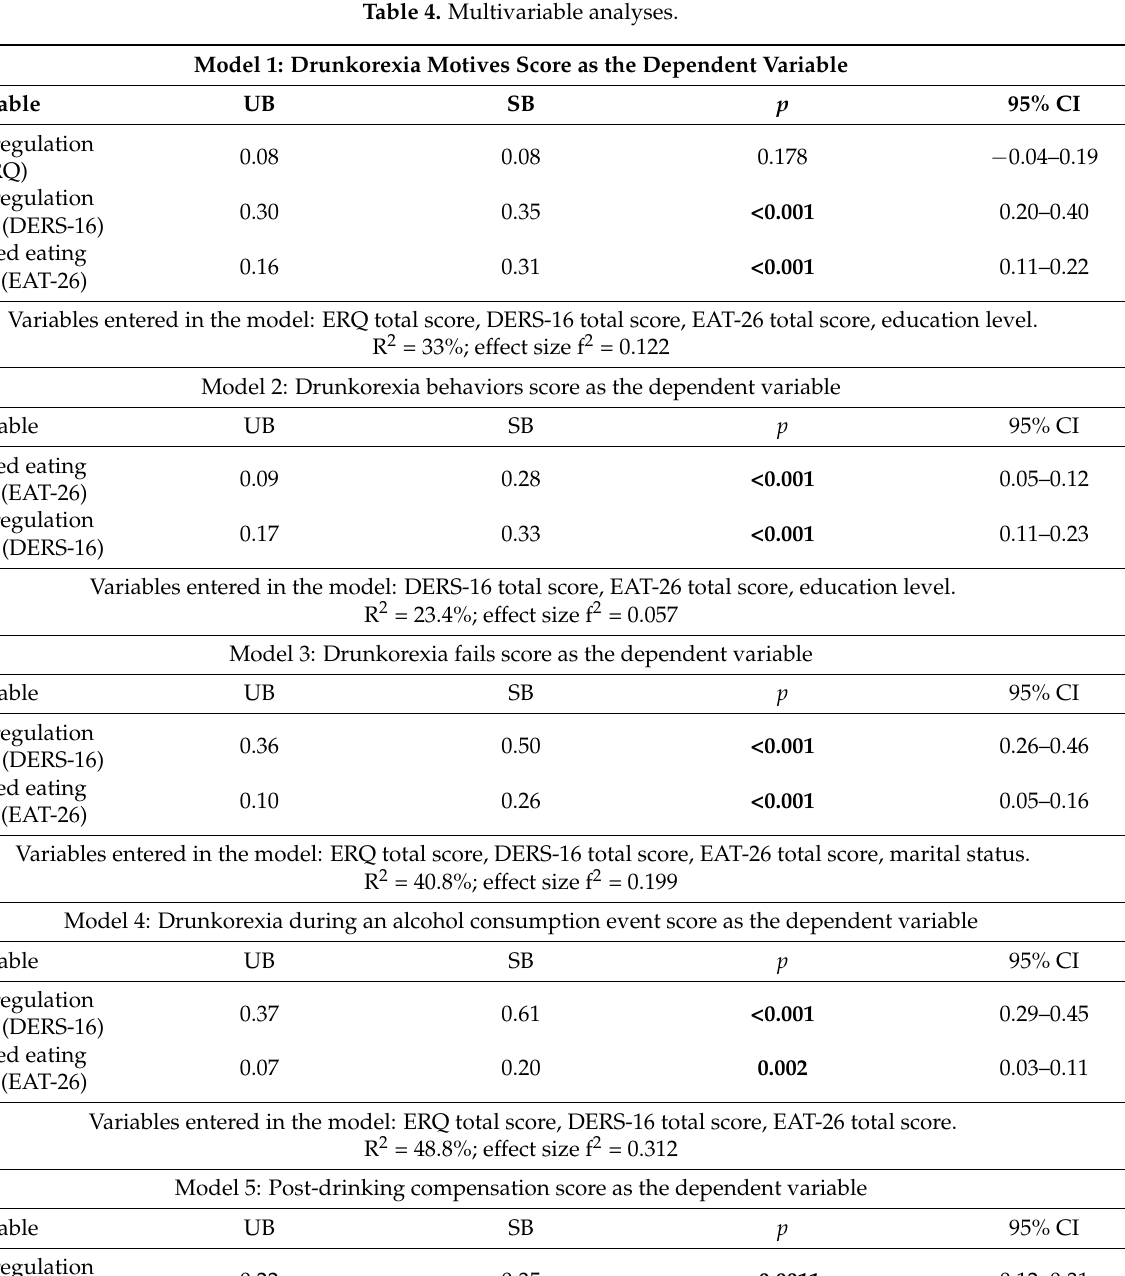
Table 4. Multivariable